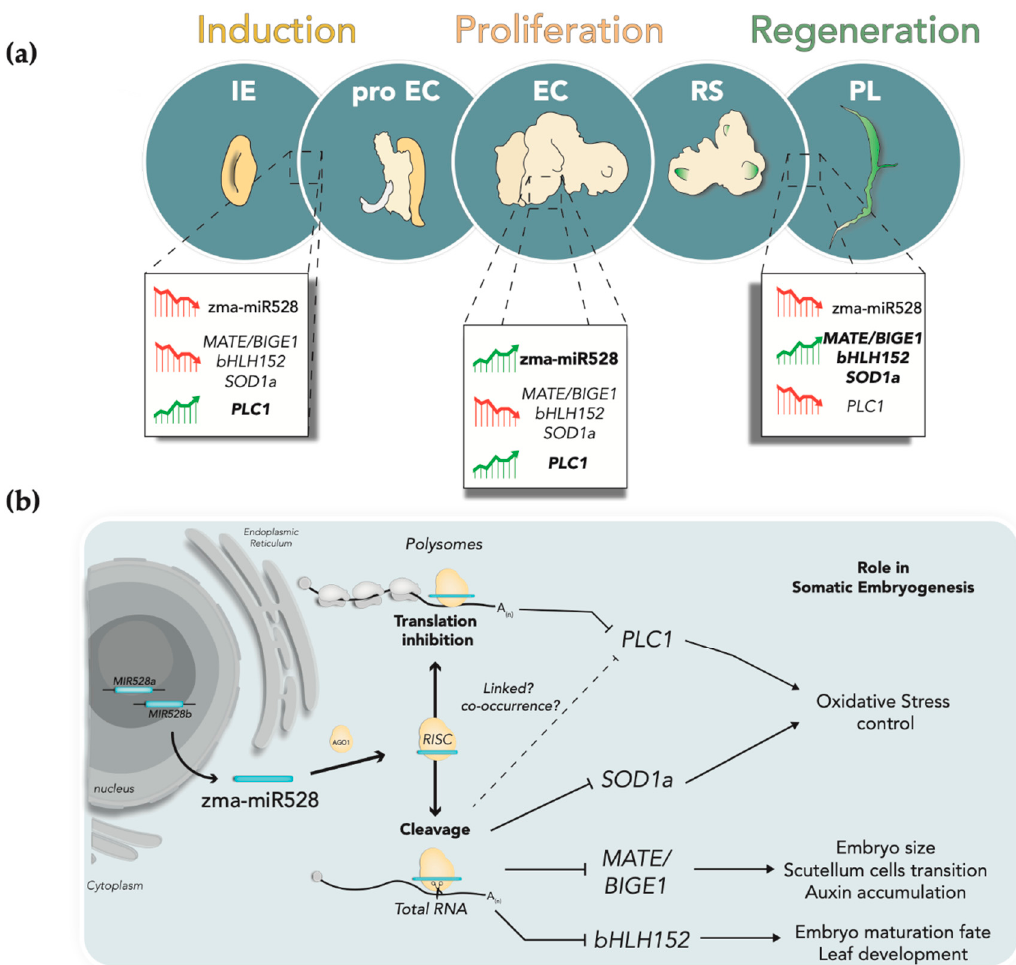
Figure 6. Mechanisms and impact of zma-miR528 target regulation during maize SE. ( a ) Zma-miR528 and its targets experience accumulation patterning during the induction, proliferation, and plantlet regeneration in maize SE. Upregulation: green upward arrow; downregulation: red downward arrow. IE: immature embryo (explant); proEC: pro embryogenic callus mass; EC: embryogenic callus; RS: regenerative spots; PL: regenerated plantlet. ( b ) Proposed model for zma-miR528 regulatory mechanisms exerted on targets. Mature miRNA arises from either of two MIR528 genes present in maize. miRNA-RISC assembles either in the cytoplasm or on membrane-bound polysomes, where zma-miR528 directs target recognition to promote target cleavage or translational repression. Mechanism selection could depend on miRNA-target kinetic parameters or the presence/absence of certain accessory proteins in the RISC complex. However, either mechanism could be linked to the production of miRNA-mediated cleavage products, as suggested in the literature [38] . According to the target function, zma-miR528 could be involved in embryogenic calli proliferation by maintaining metabolic and physiologic processes required for SE.